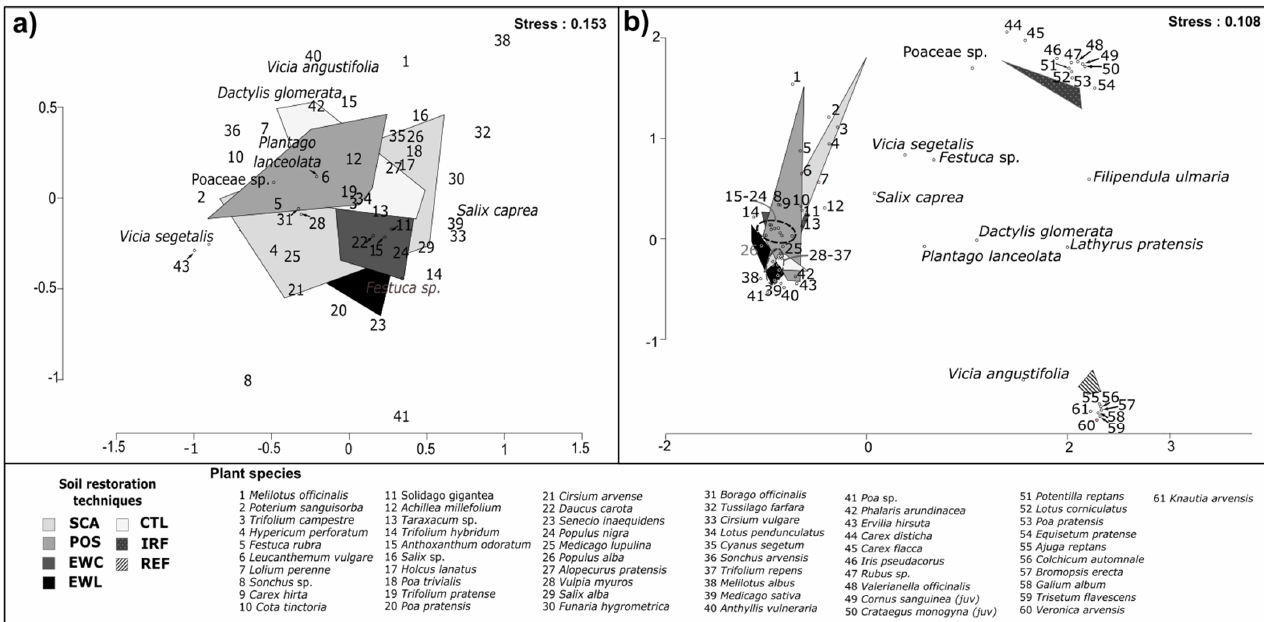
Figure 5. Nonmetric multidimensional scaling (NMDS) of plant species communities observed on the treated and reference sites. See the Material and Methods section for soil restoration technique abbreviations. ( a ) NMDS on experimental plots and references; ( b ) NMDS on experimental plots only to highlight the potential impact of the different techniques.